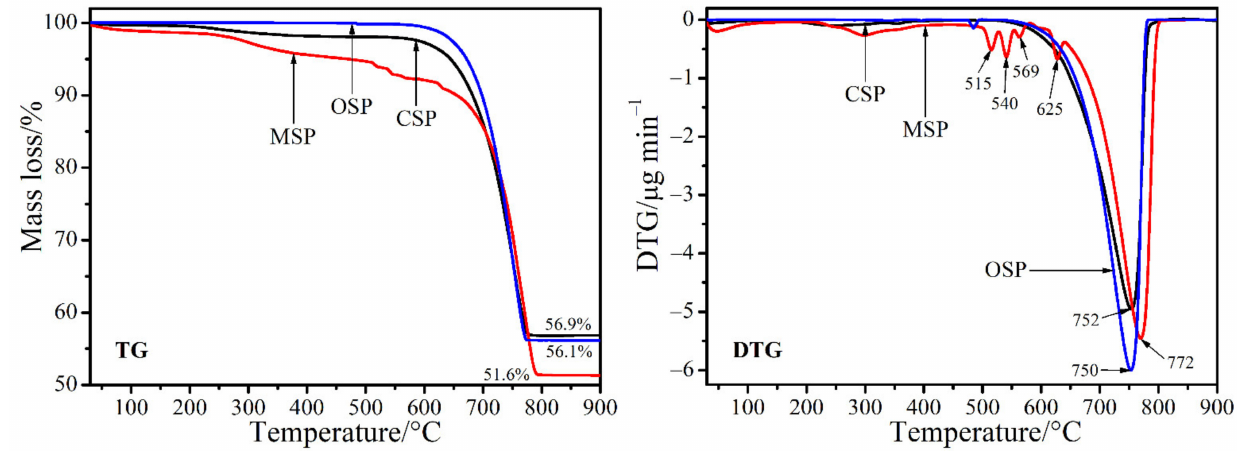
Figure 2. TG and DTG curves of the bivalve shell (CSP, MSP and OSP)